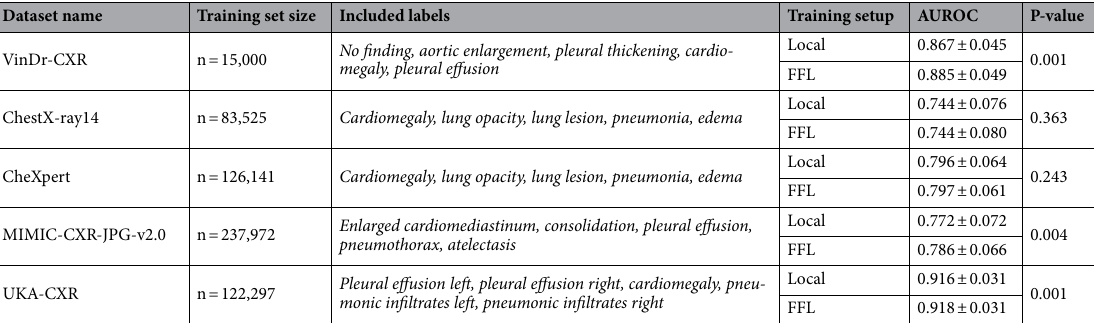
Table 3. Results of the comparison between local and FFL-based training for 5 different datasets. Average AUROC values over all included labels for each dataset, tested on the test benchmark of the corresponding dataset. The FFL process for each dataset was performed in combination with the other 4 datasets including 5 different labels for each